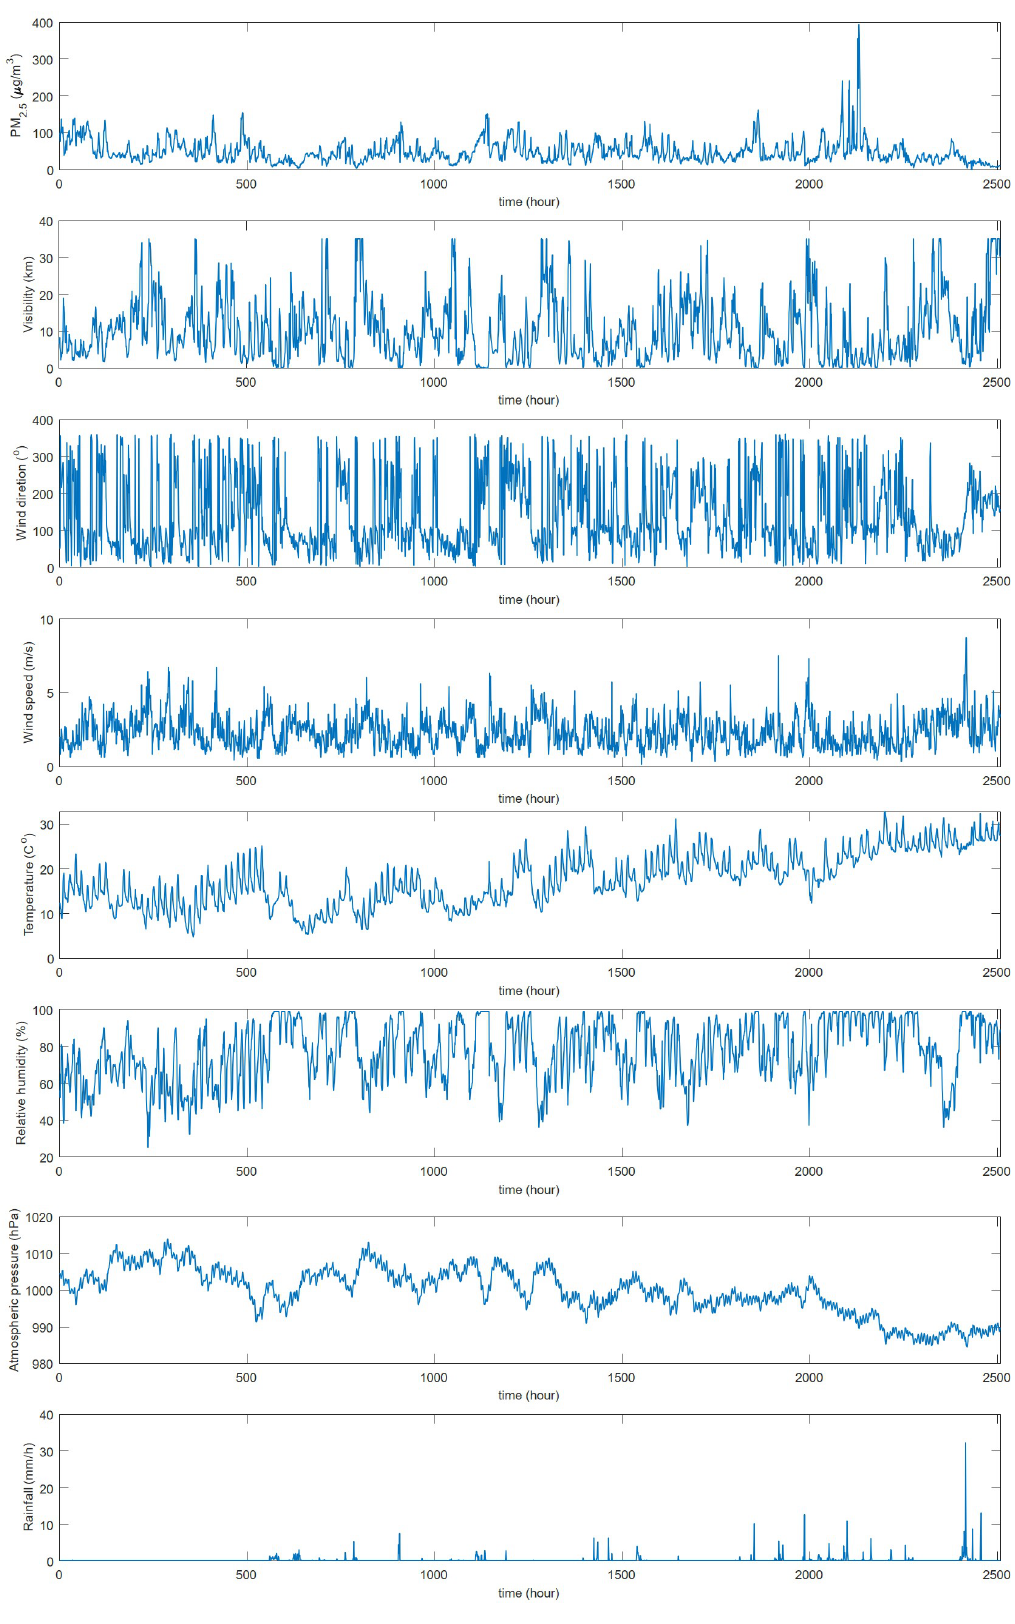
Figure 1. This figure shows temporal variations of PM 2.5 concentrations and meteorological parameters at National Xiamen weather station during the period of Jan 2014 – June 2014.